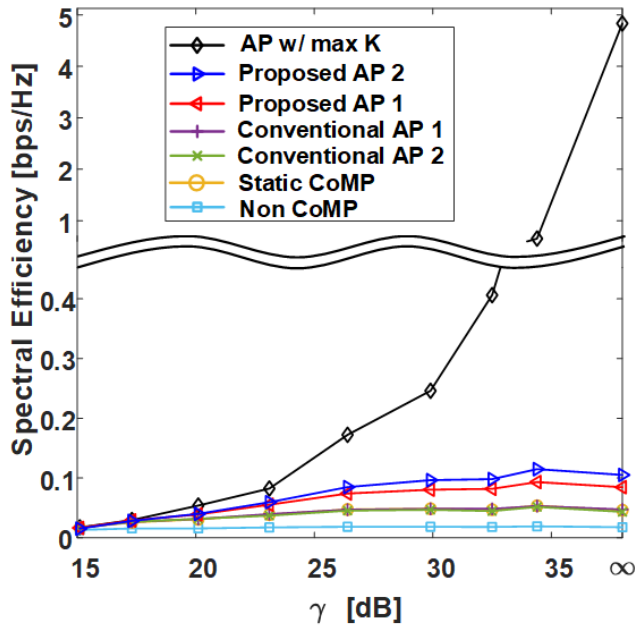
Figure 10. Spectral efficiency at 5% outage level of various clustering schemes with respect to γ in grid topology.